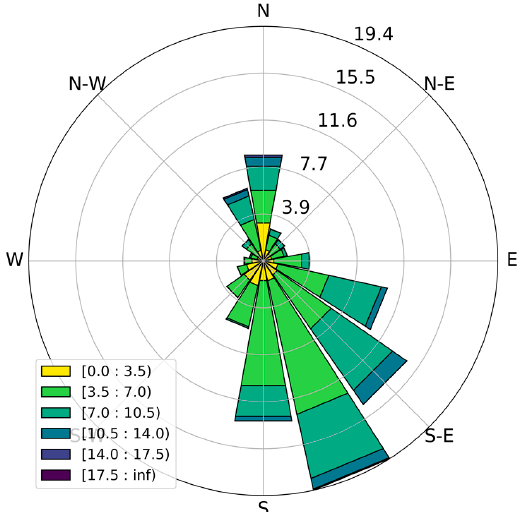
Figure 4. Wind rose of the data. Dominant winds are mainly distributed from the south to south-east